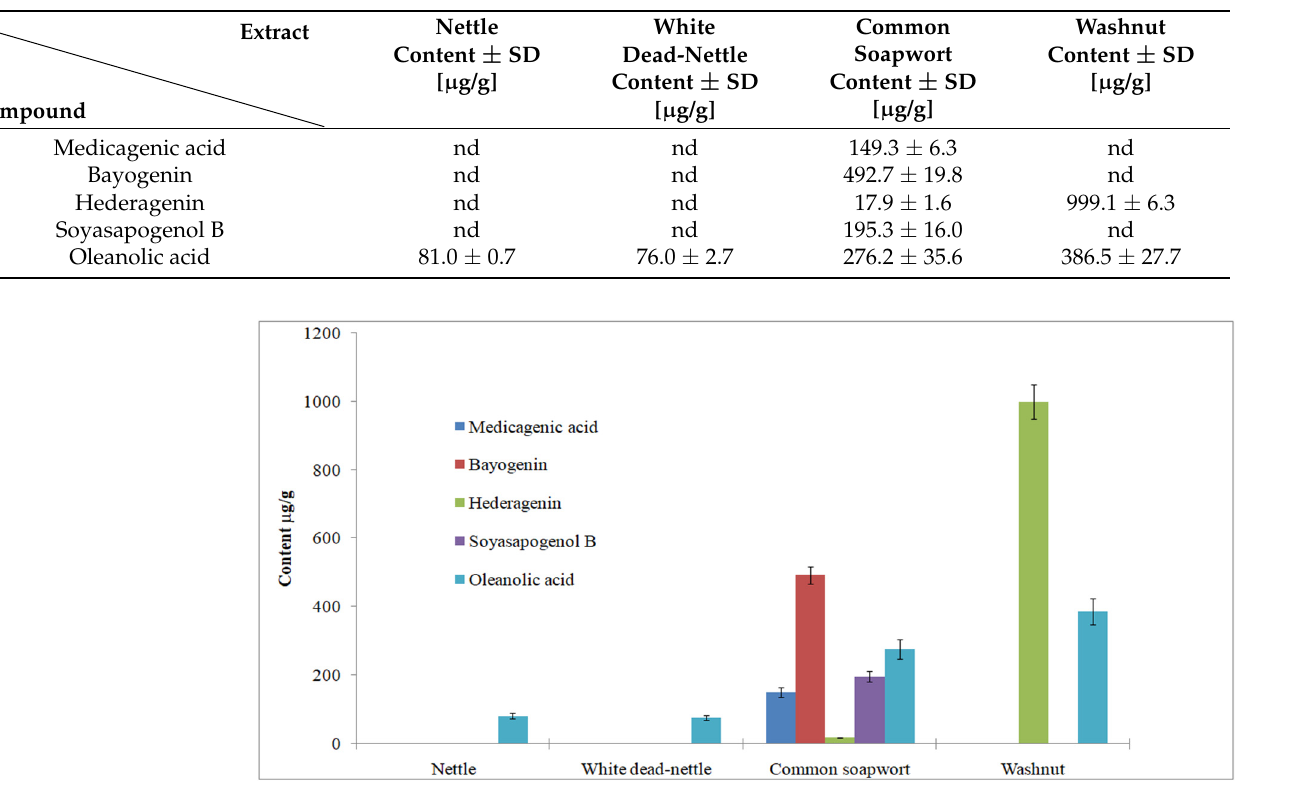
Figure 4. The quantitative content of medicagenic acid, bayogenin, hederagenin, soyasapogenol B and oleanolic acid in extracts of nettle, white dead-nettle, common soapwort and washnut.